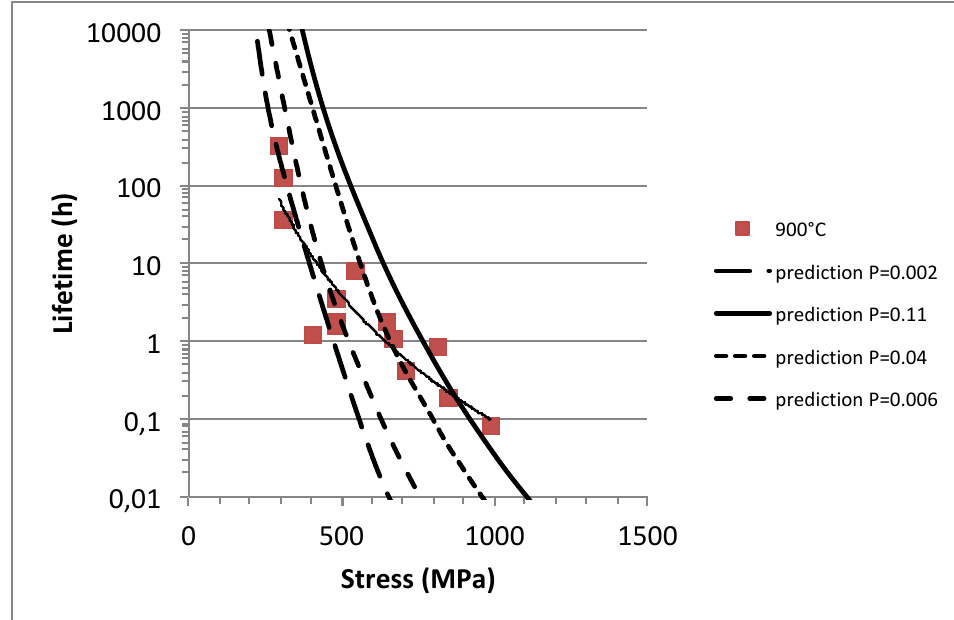
Figure 4. Static fatigue at 900 °C on minicomposites: comparison with stress–rupture time curves for critical filaments.